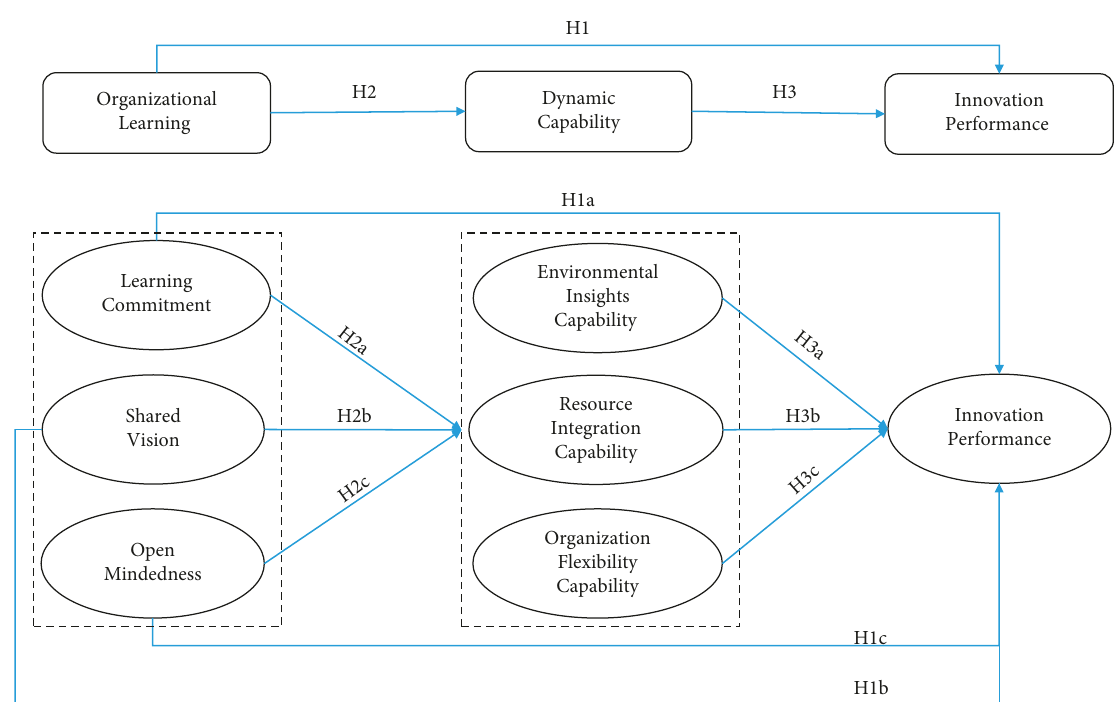
Figure 2: Conceptual model of organizational learning, dynamic capabilities and innovation